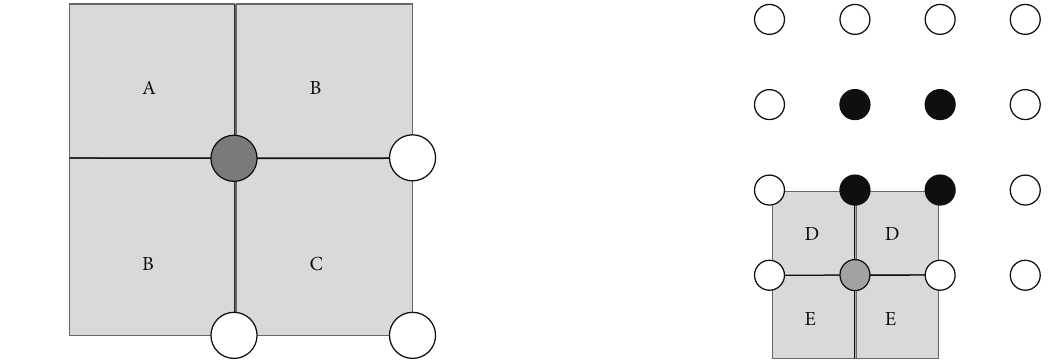
Figure 10: Constellation diagram and ACE decision regions for the marked symbol of